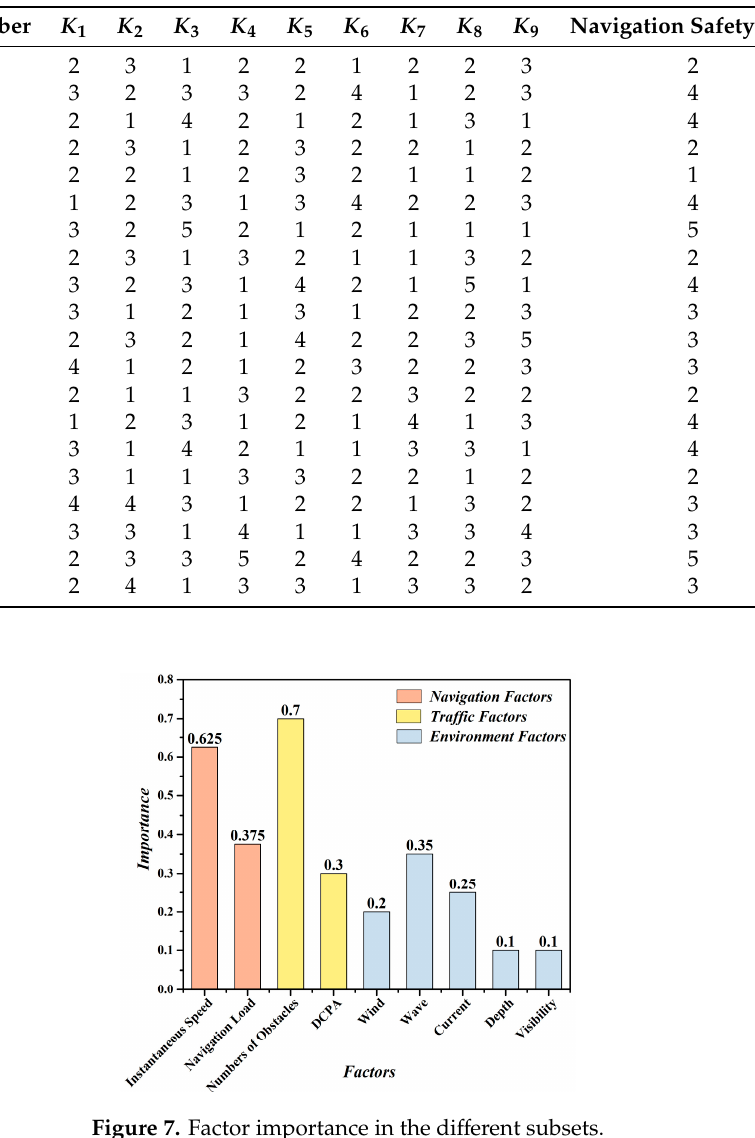
Figure 8. Factor importance after normalization.